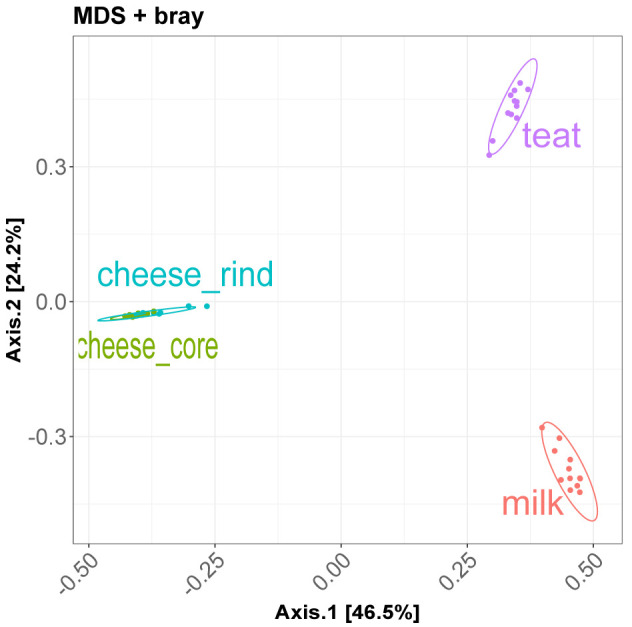
Ordination plot: MDS on Braycurtis distance.